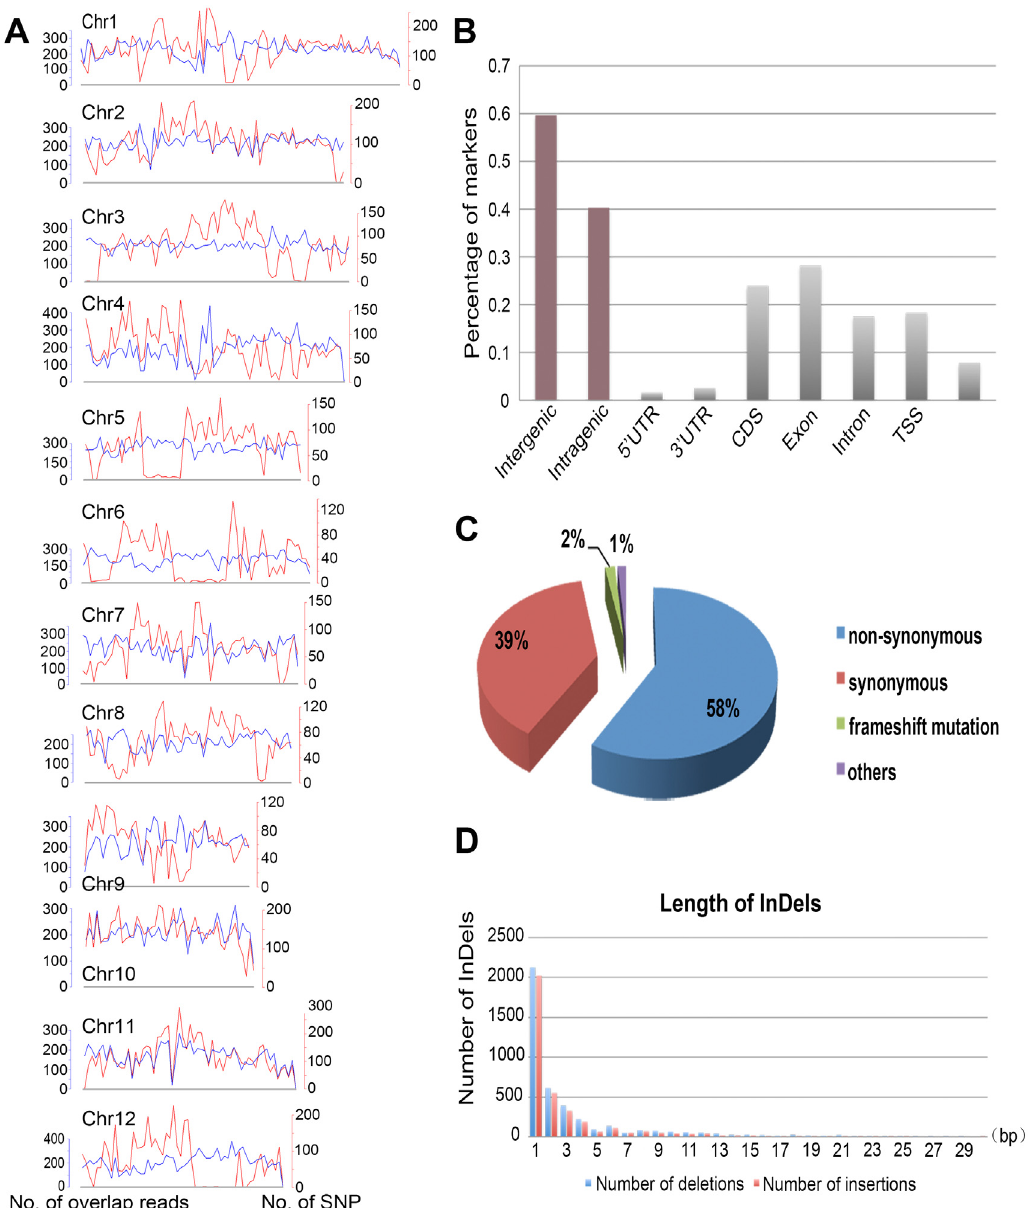
Fig 4. Marker distribution and annotation. (A) Distribution of the number of overlapping reads and SNPs between Jiaoyuan5A and JP69 along each chromosome in 500 kb windows. (B) Distribution of 90,743 markers in different genomic regions. The X axis indicates different genic regions; The Y axis indicates the number of markers. (C) Functional relevance of polymorphisms located in the coding regions. (D) Length of insertions and deletions. The X axis shows the length of insertions (shown in red) and deletions (shown in blue). The Y axis shows the number of insertions and deletions at each